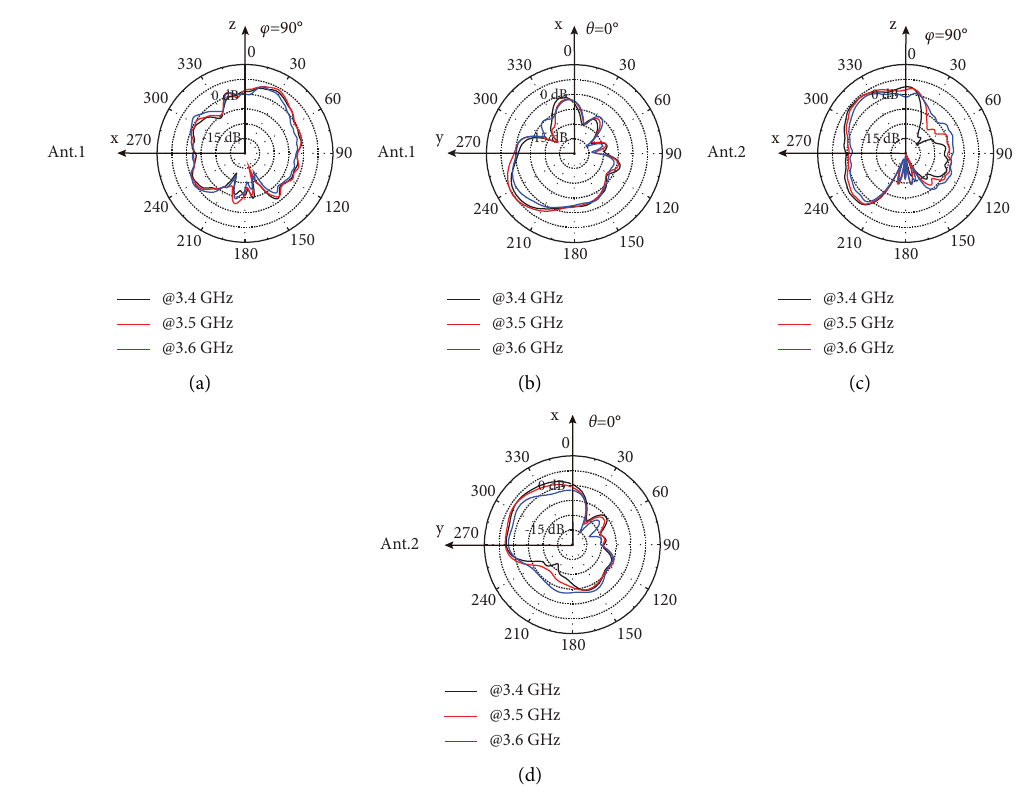
Figure 9: Measured radiation patterns of Ant.1 and Ant.2 in (a), (c) x - z planes, (b), (d) x - y Table 1: Comparison with existing works. Reference